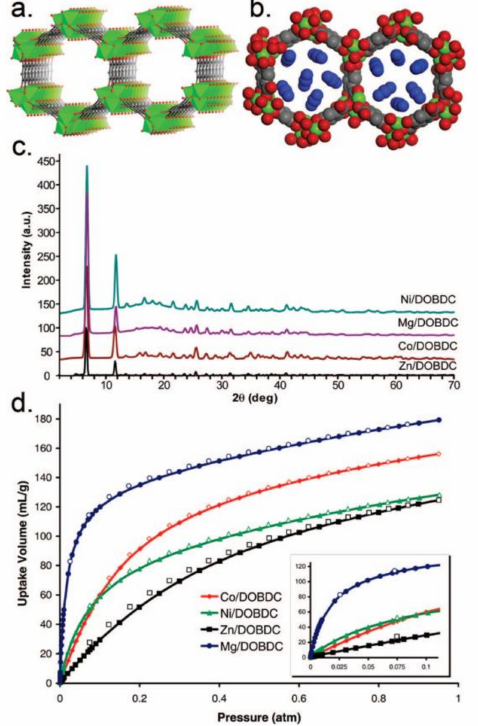
Figure 2. ( a ) The 1D channels of MOF-74-Mg, Mg-DOBDC (solvents omitted). ( b ) Space-filling model of the pore structure of MOF-74-Mg (Mg, green. C, grey. O, red). ( c ) PXRD data for the isostructural MOFs M-DOBDC (M = Zn, Co, Mg, Ni). ( d ) CO 2 sorption isotherm (296K, 0 to 1 atm) of the isostructural MOFs M-DOBDC (inset: CO 2 sorption isotherms at 296 K, 0 to 0.1 atm). Reprinted with permission from J. Am. Chem. Soc. 2008, 130, 10870–10871 ([57]). Copyright 2008 American Chemical